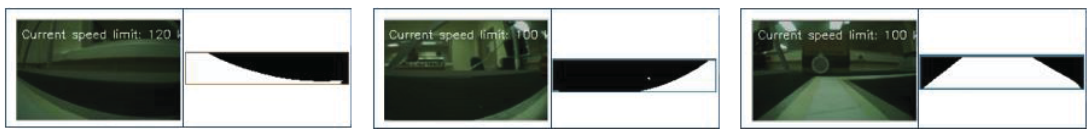
Figure 13. Experimental detection of tracks in a real environment.